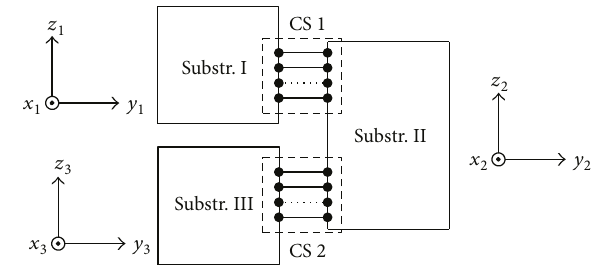
Figure 3: Substructure system with three